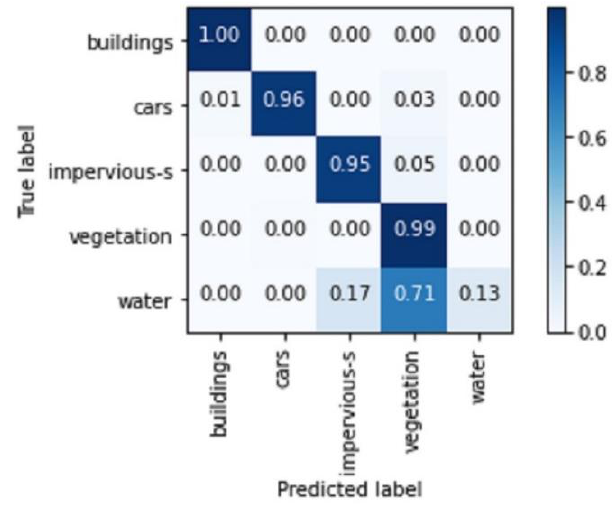
Figure 8. The Normalized confusion matrix.